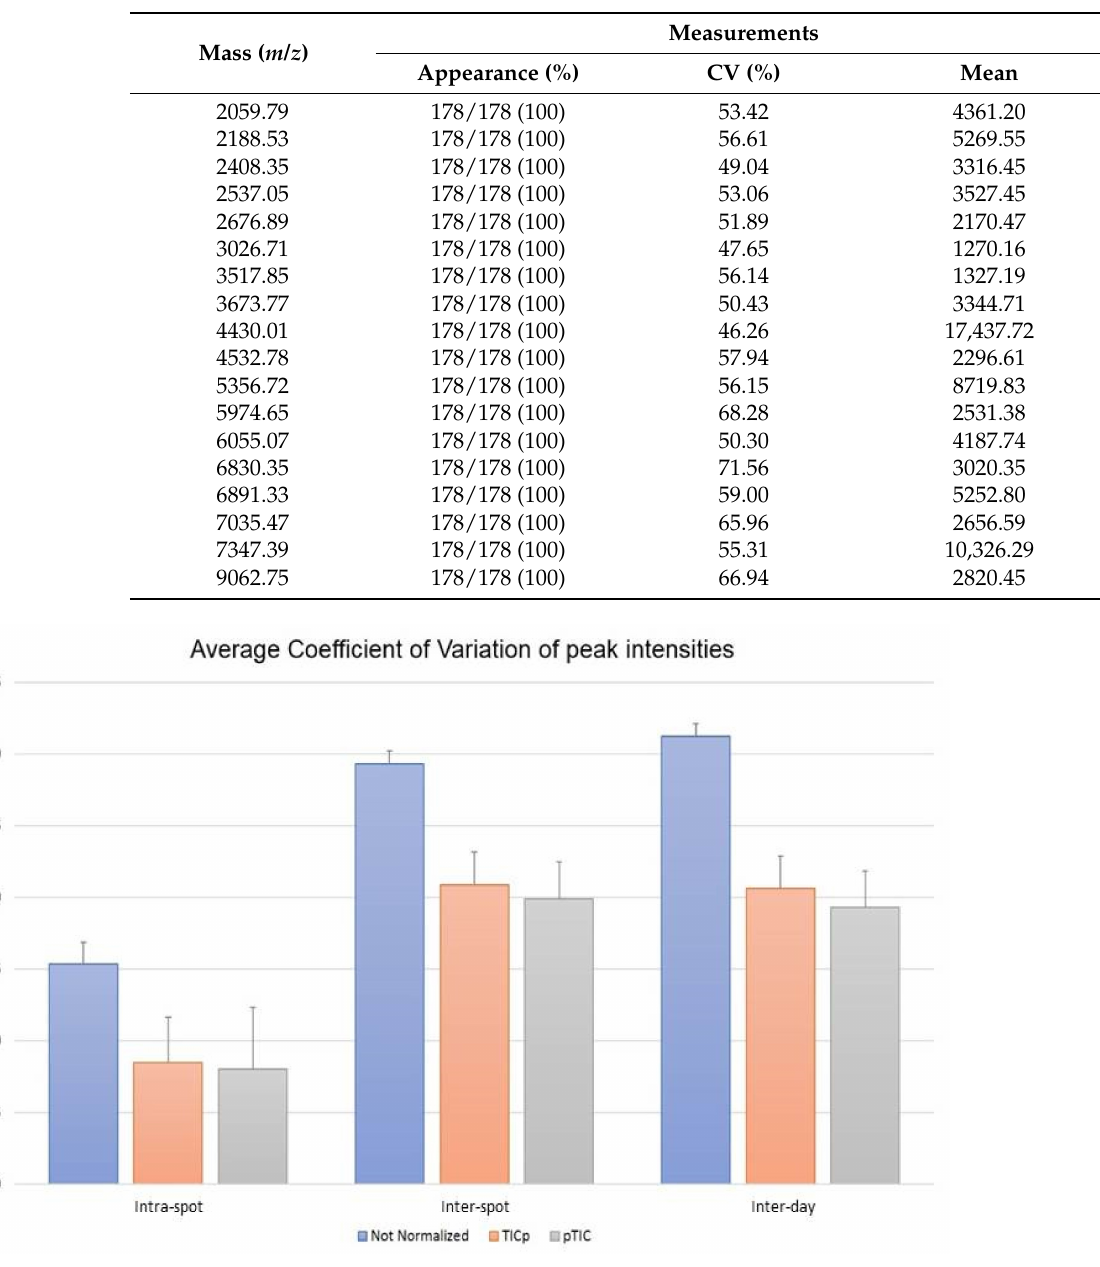
Table 1. List of common peaks ( n = 18) found in the average spectra of the vancomycin- resistant E. faecium and vancomycin-susceptible E. faecium isolates included in the classification set. CV = coefficient of variation of intensity. Mean in intensity units.